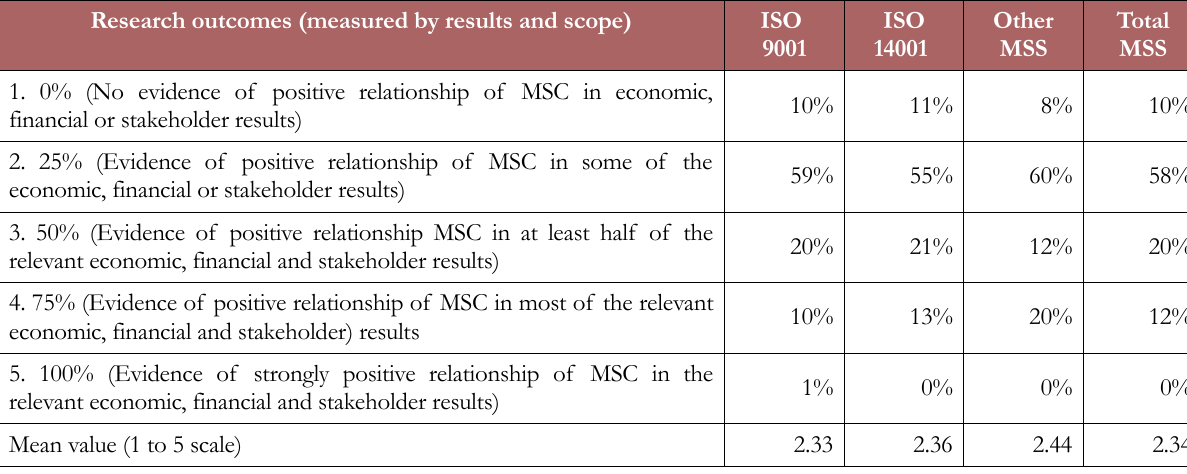
Table 3. Evaluation scale to access benefits of